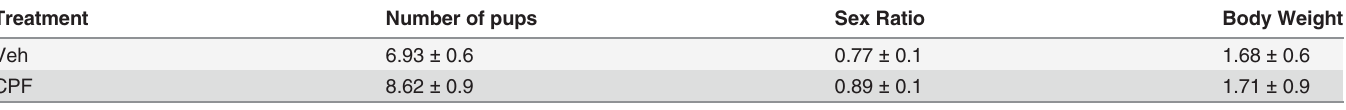
Table 1. Reproductive performance data of BTBR females receiving 6 mg/kg/bw CPF or Veh from GD 14 to 17.